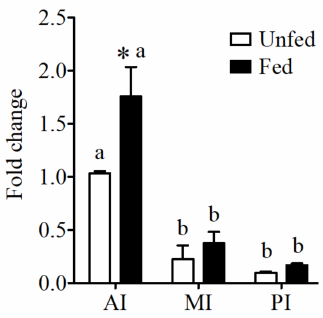
Figure 1. CaSR expression in anterior intestine (AI), mid intestine (MI), and rectum of the sea bream intestine in fed and unfed conditions. CaSR expression was normalized by 18S and expression levels are presented as fold-change from anterior intestine of unfed fish. The results are shown as mean ± SE ( n = 5–7); differences among groups were evaluated by two-way ANOVA (followed by a Bonferroni post-hoc test), with feeding conditions and intestinal segment as independent variables within feeding groups different letters represent significantly different levels, between the same regions, * represents significant effects p < 0.05.